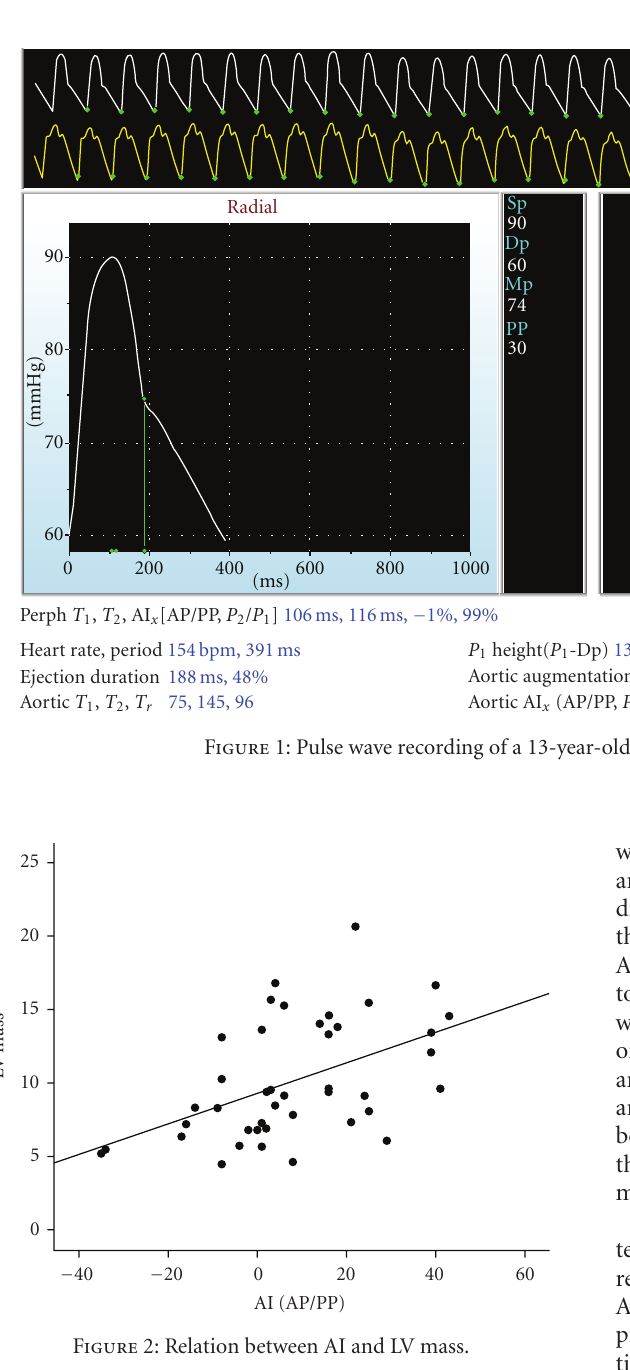
80%, and from the CA in 50% of macaques